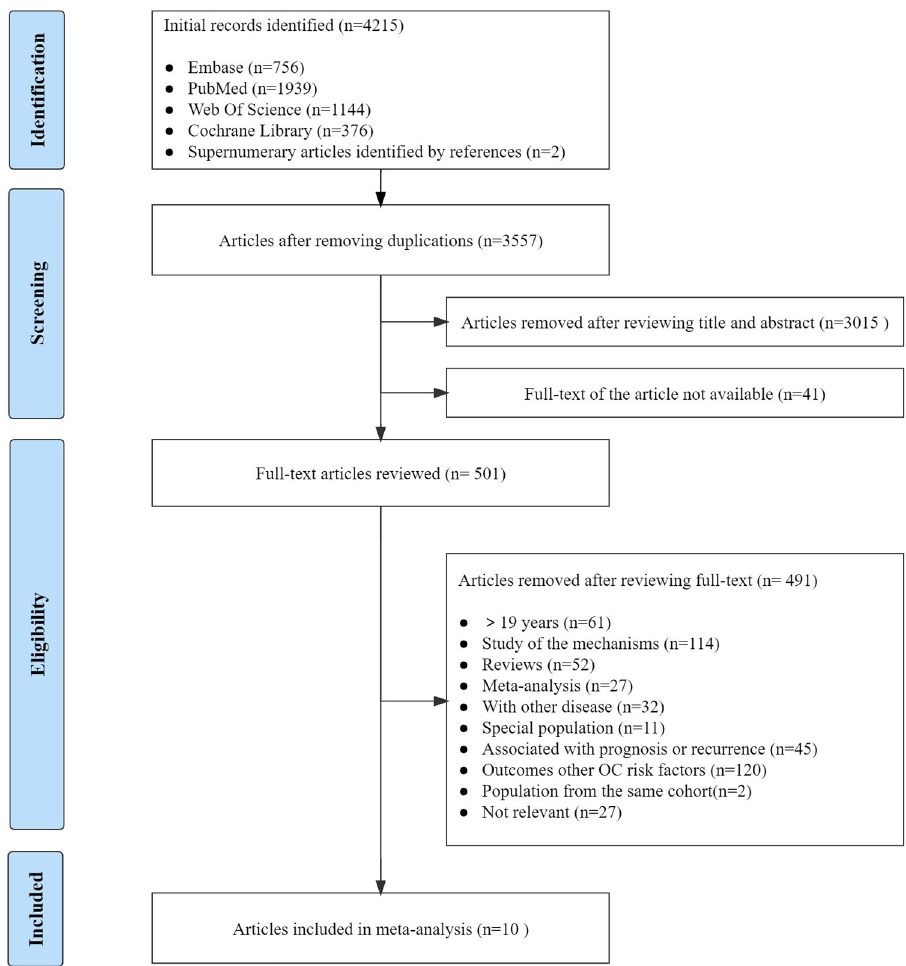
Fig 1. Flow chart of study selection in this